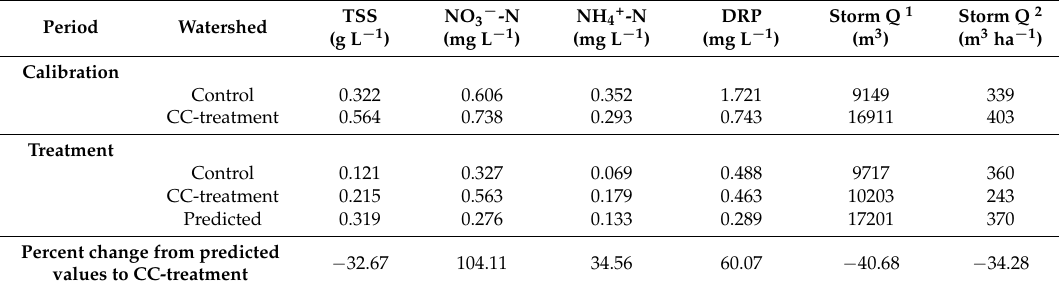
Table 6. Event mean concentrations representing 42 storm events collected during the calibration period and 18 during the treatment period. Predicted values are calculated from the equations in Table